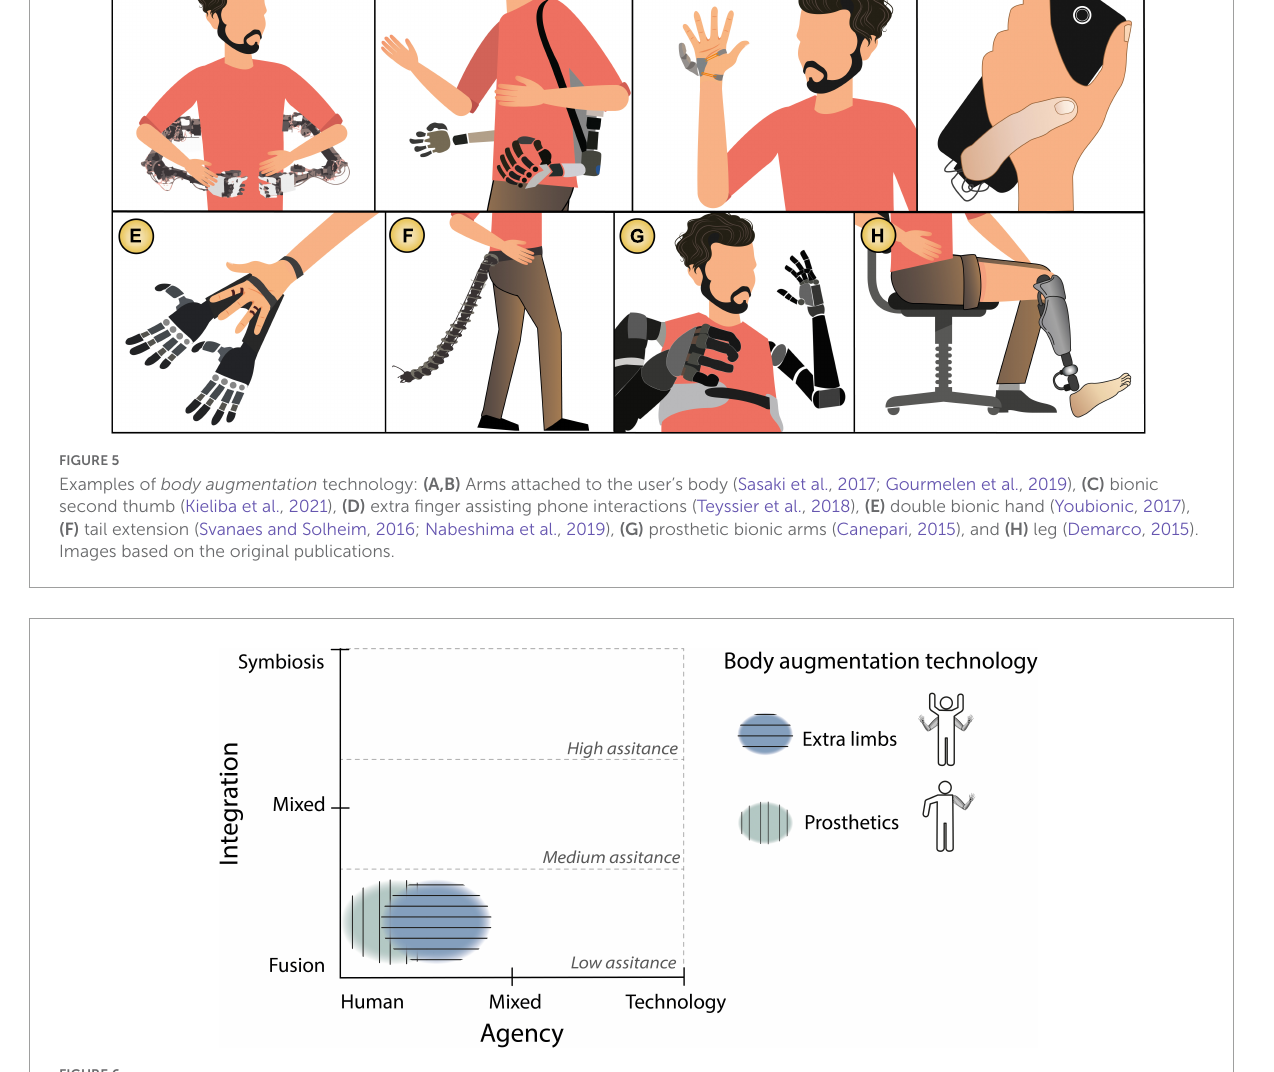
FIGURE6 Map of the three types of body augmentation technology that we identified (extra limbs and prosthetics) and their relationship with assistance level, agency, and